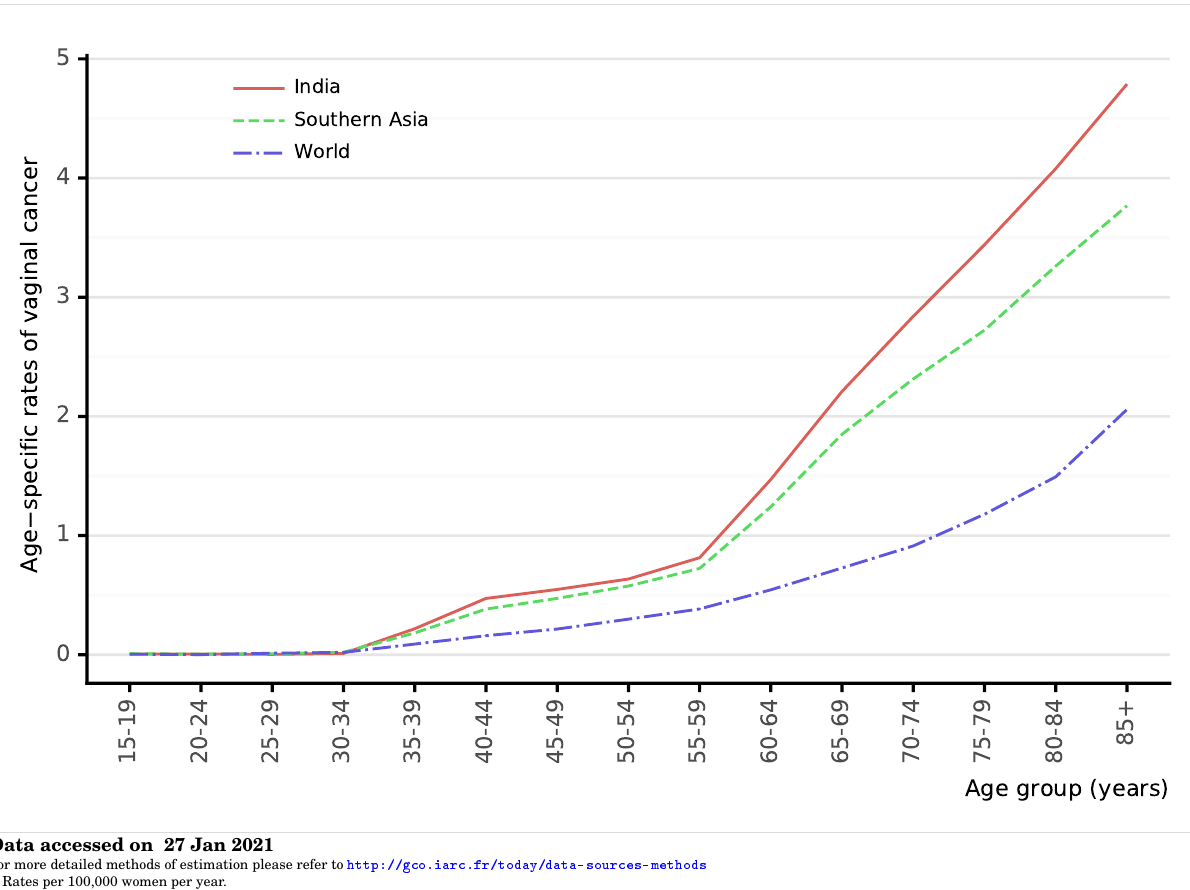
Figure 118: Comparison of age-specific vaginal cancer mortality rates in India, within the region, and the rest of